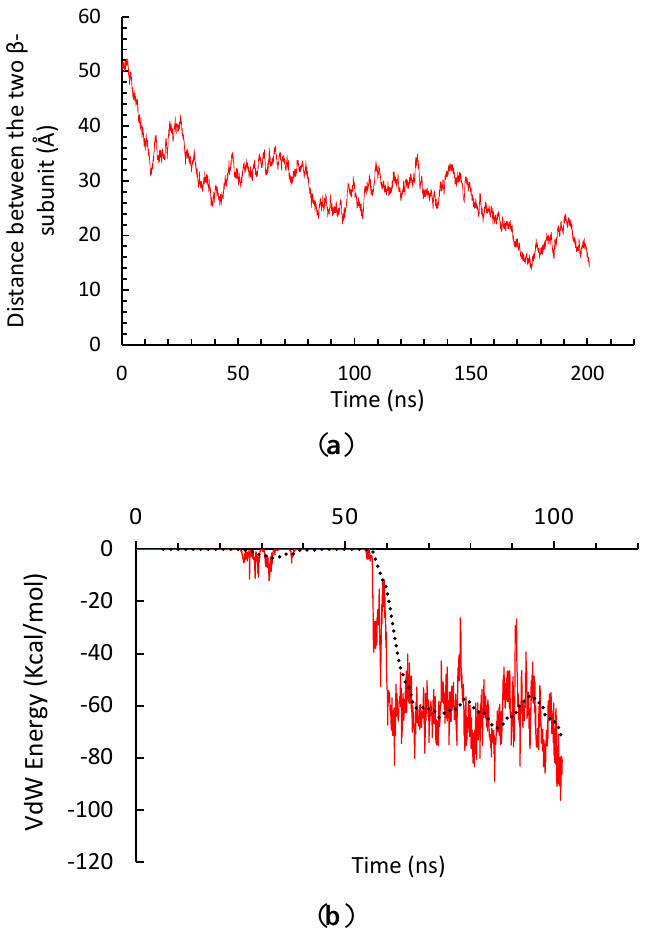
Figure 10. ( a ) Distance between the center of mass of the two β-subunit in CG simulation. ( b ) Van der Waals energy of the two β-subunit monomers.